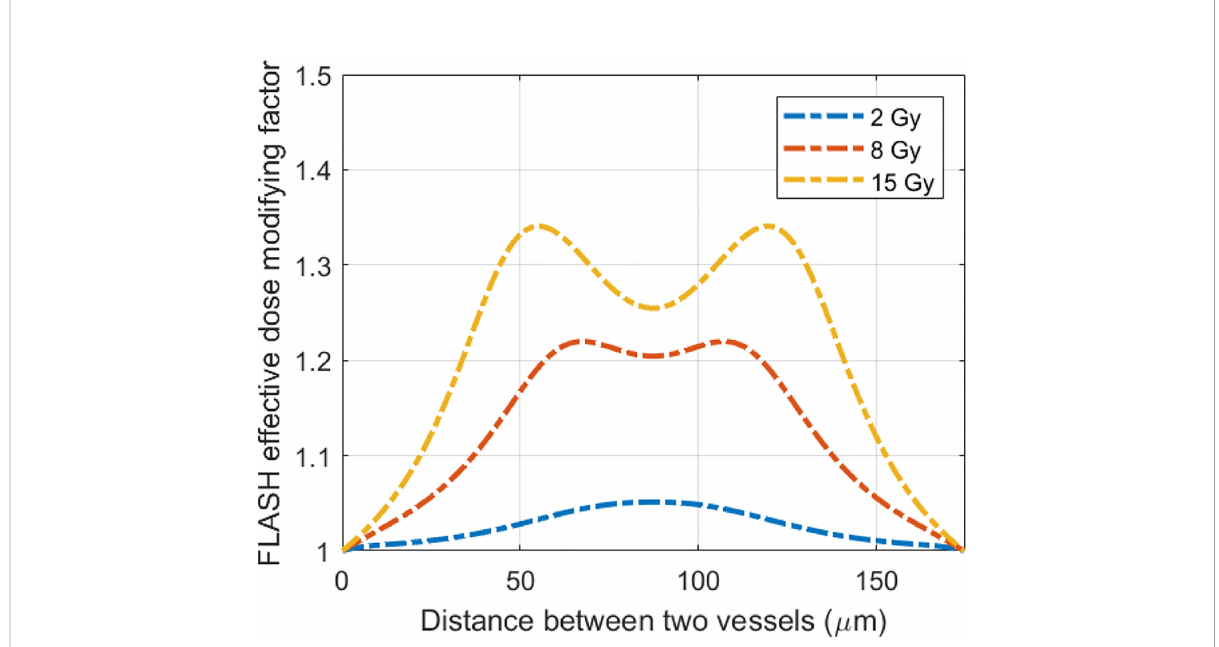
FIGURE 6 The delivered dose makes a difference in the FLASH effective-dose-modifying factor. Plotted are the FLASH effective-dose-modifying factors from 15 Gy delivered at 0.5 and 125 Gy/s dose rates for 175 m m vasculature spacing and 18.9 m M